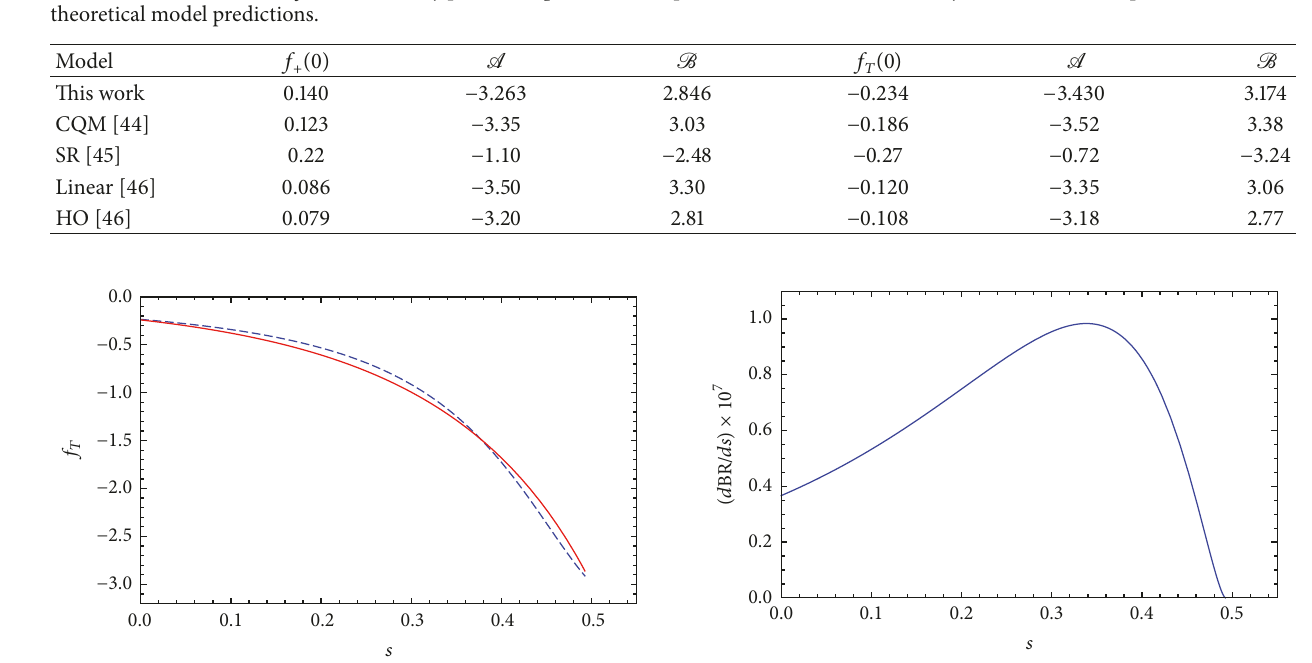
Figure 4: Differential branching ratios as a function of 𝑠 for 𝐵 + 푐 → 𝐷 + ]] . 𝑐